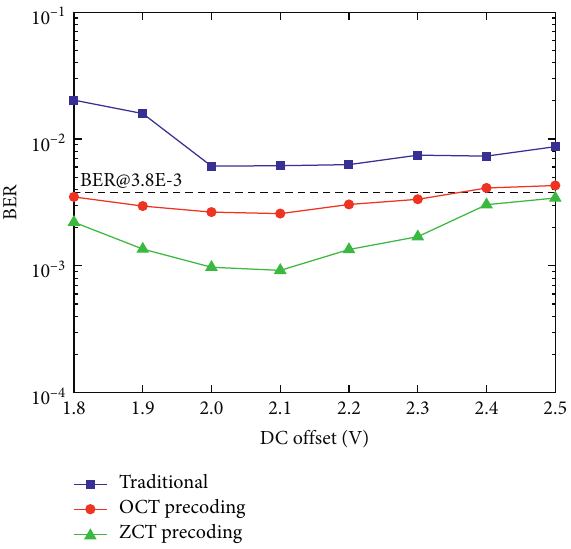
Figure 6: BER versus DC offset (Vpp �